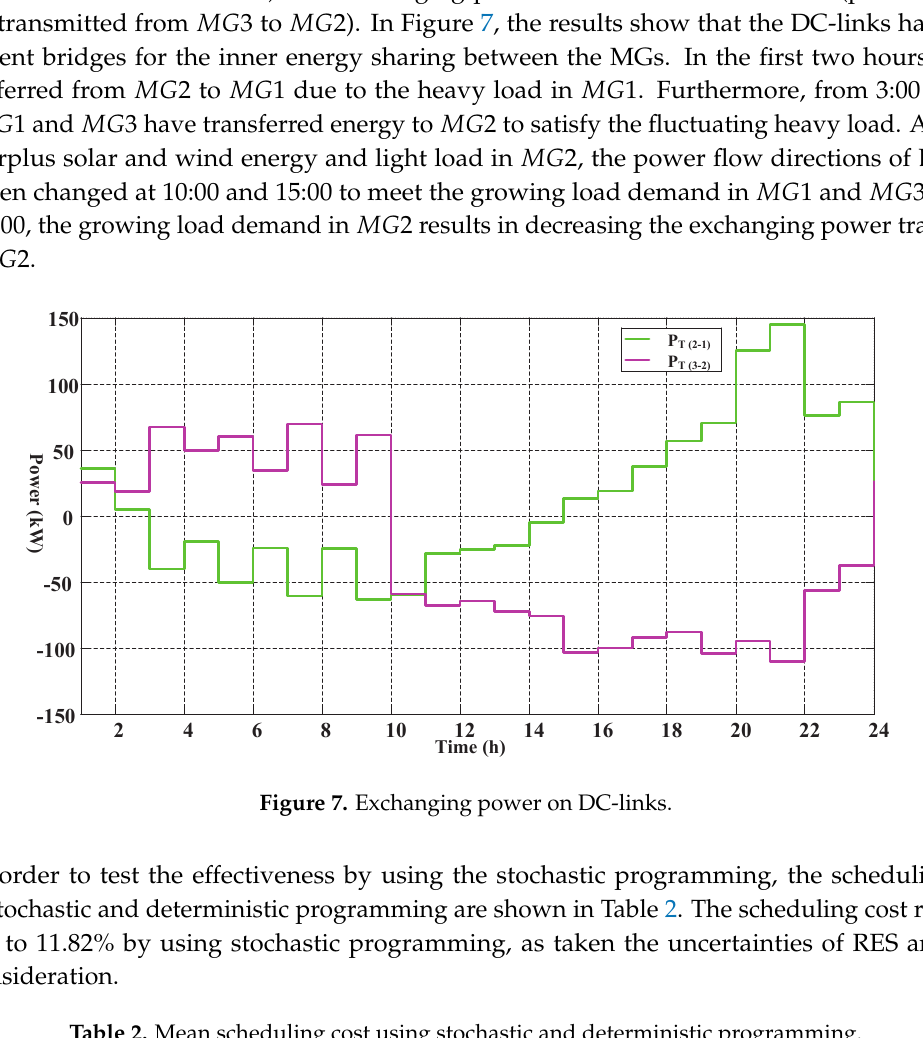
Table 2. Mean scheduling cost using stochastic and deterministic